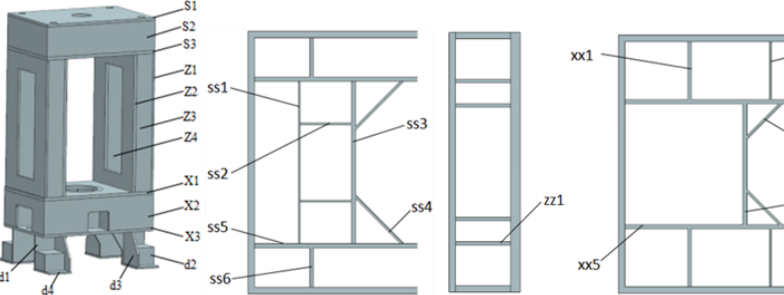
Figure 17. Position distribution of sheet metal.